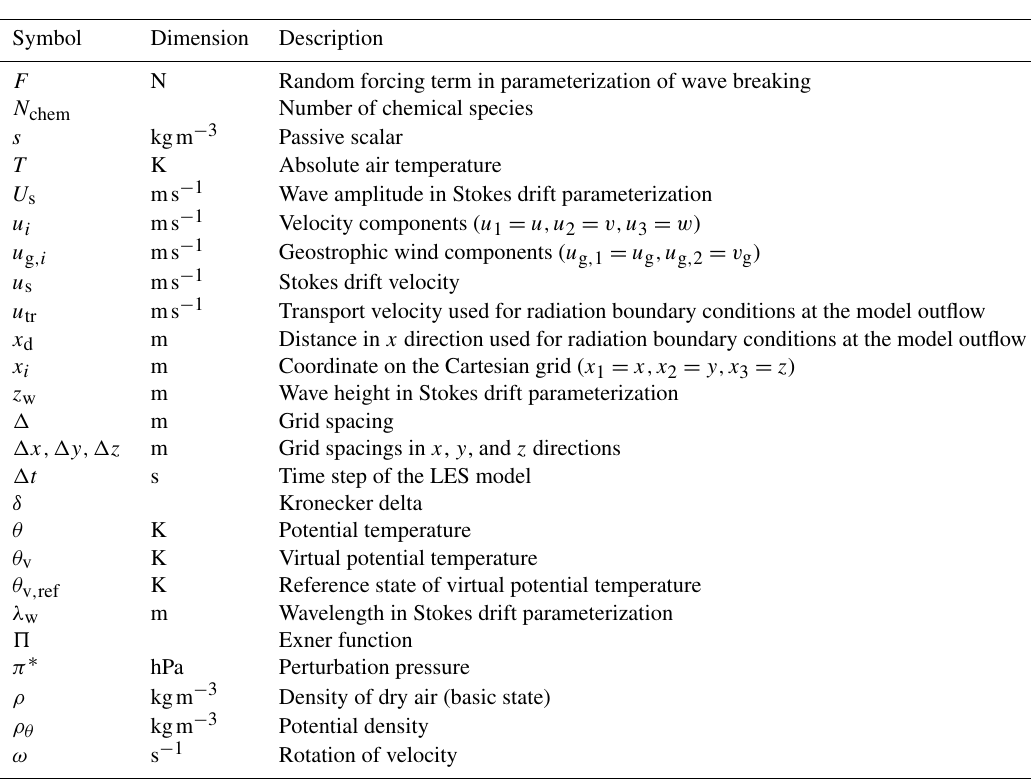
Table 2. List of general symbols.